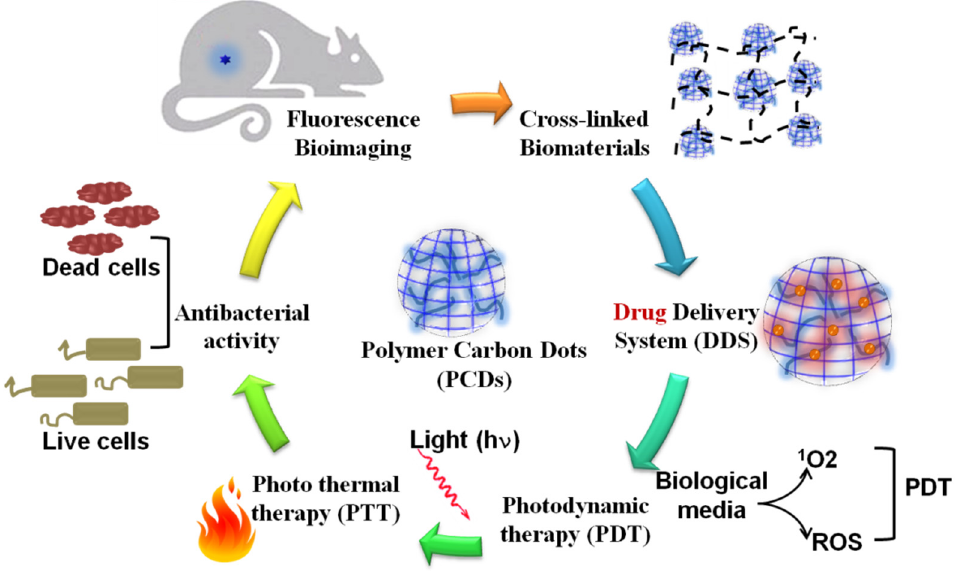
Figure 3. Schematic description of PCDs based different delivery system and their potential bio- medical applications. cal